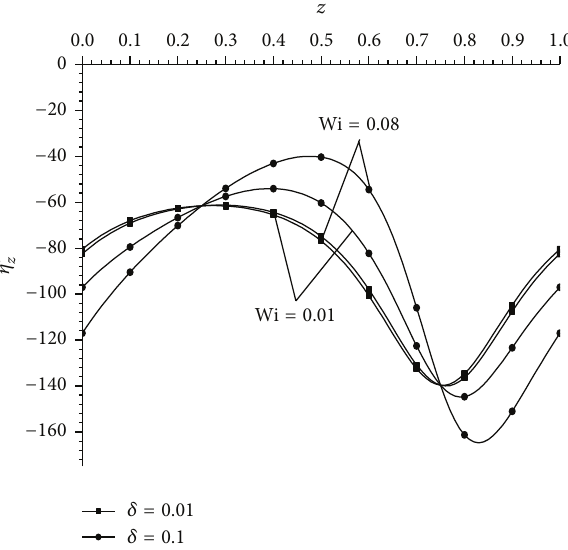
Figure 7: Variation of wall vorticity 𝜂 𝜖 𝑧 versus 𝑧 with different values of 𝛿 and Wi at Re = 5 , 𝜖 = 0.01 , 𝑄 = 1.5 , and 𝜙 = 0.4 .